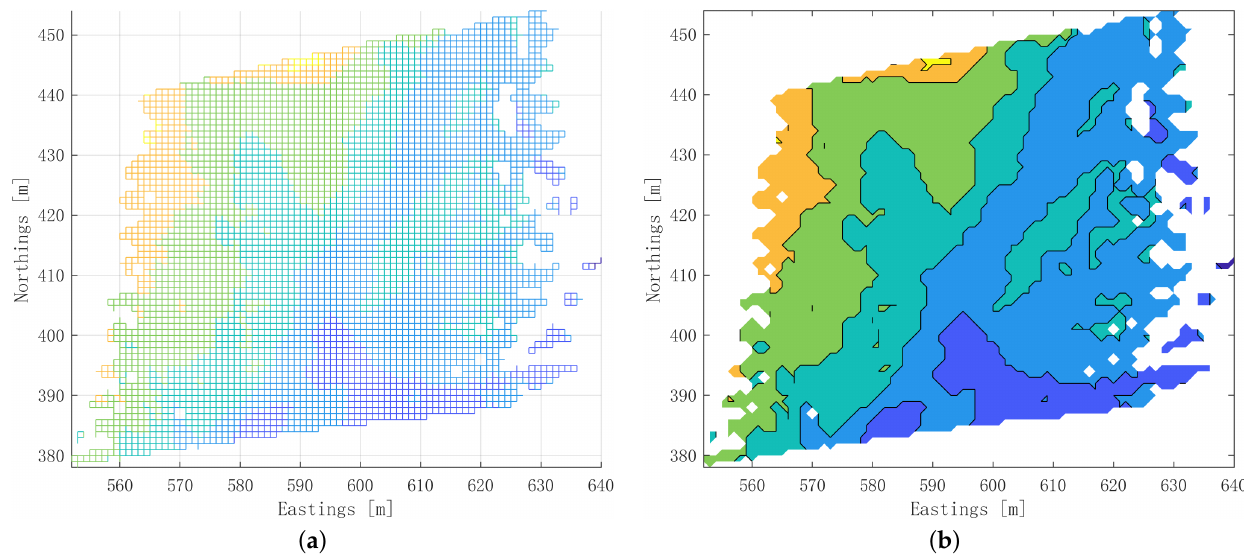
Figure 4. Girding approach. ( a ) A representation of the test map as a girding map. ( b ) Contour map generated from the girding map (Figure 4a).